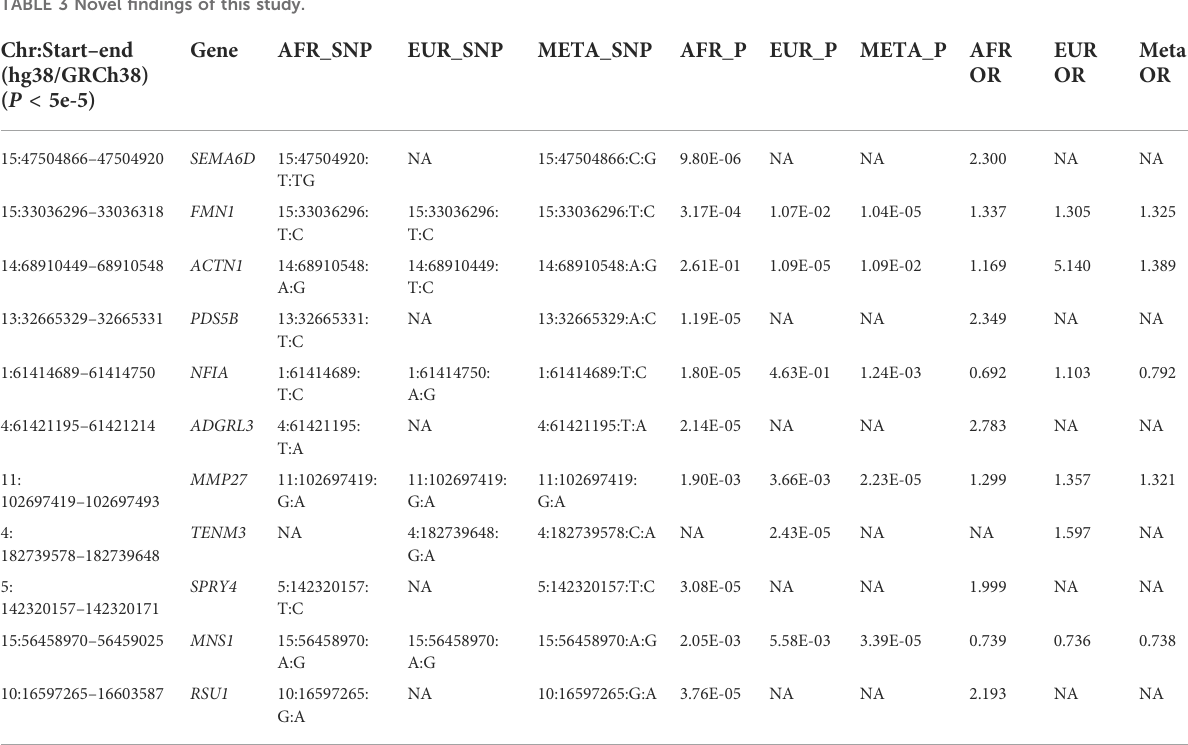
TABLE 3 Novel fi ndings of this